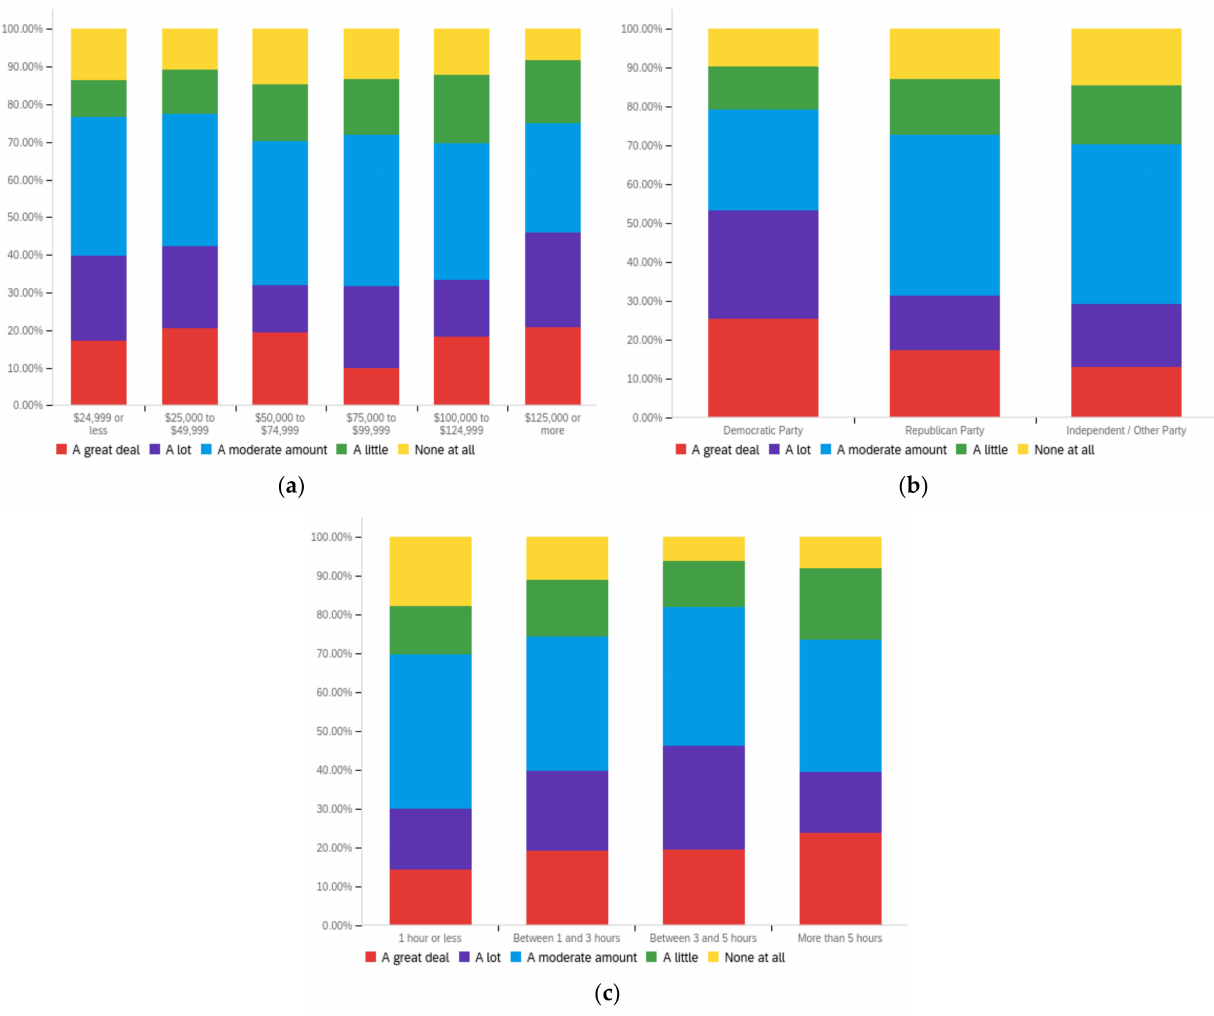
Figure A27. Article opinion statement quantity—ideal perception impact by: ( a ) income level (top left), ( b ) political affiliation (top right) and ( c ) online usage